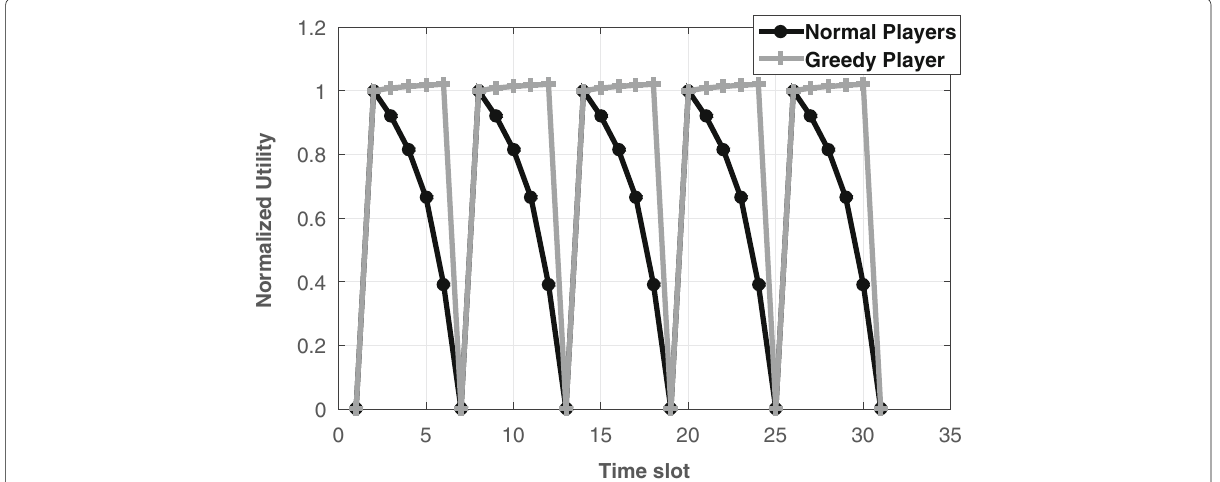
Fig. 9 Greedy player in a queue with n s = 2, n p = 2, λ p = 10 kbps, λ s = 1 kbps, μ = 100 kbps, e g = 1.05, and e v = 1.2 for the Stackelberg games in Section 3.2 and cost function defined in Eq.